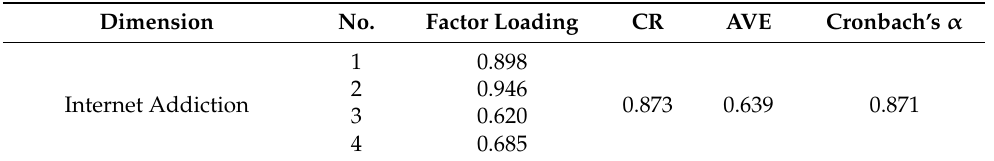
Table 2. Reliability and validity assessment of internet addiction scale. Dimension No. Factor Loading CR AVE